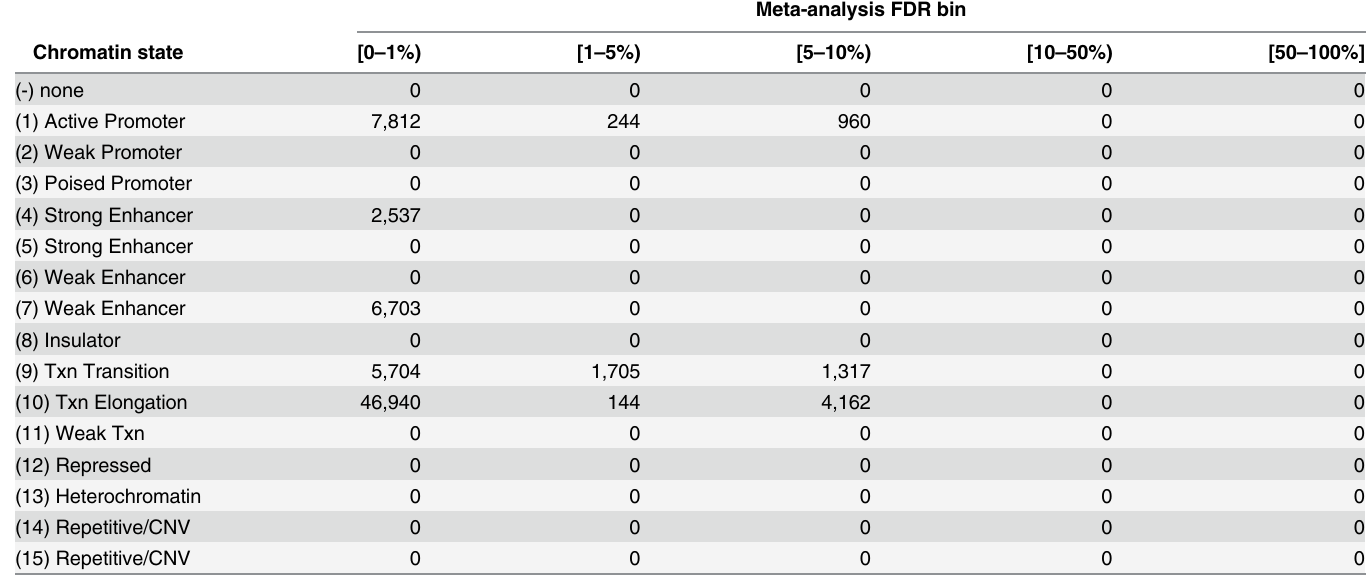
Table 2. Functional annotations of SNP-pairs most strongly predicted to be in GWAS loci.